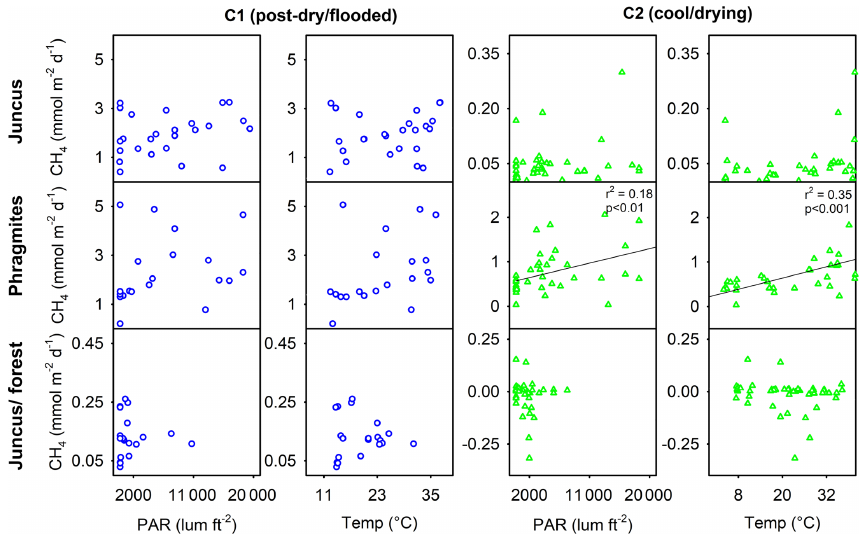
Figure 6. Correlations of CH 4 with temperature ( ◦ C) and photosynthetically active radiation (PAR) (lumft − 2 ) for the three wetland vegeta- tion sites of Cattai Wetlands during two field campaigns.